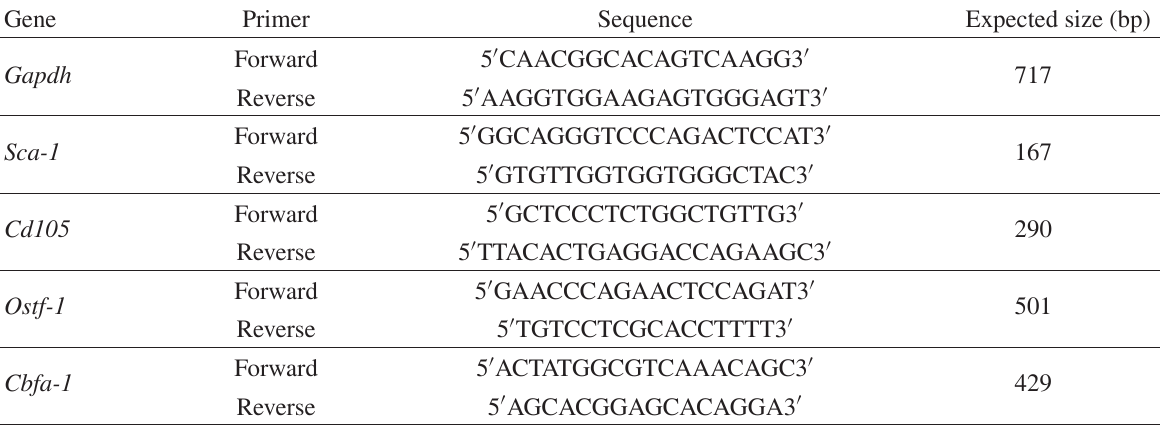
TABLE 1: Primer sequences used in RT-PCR